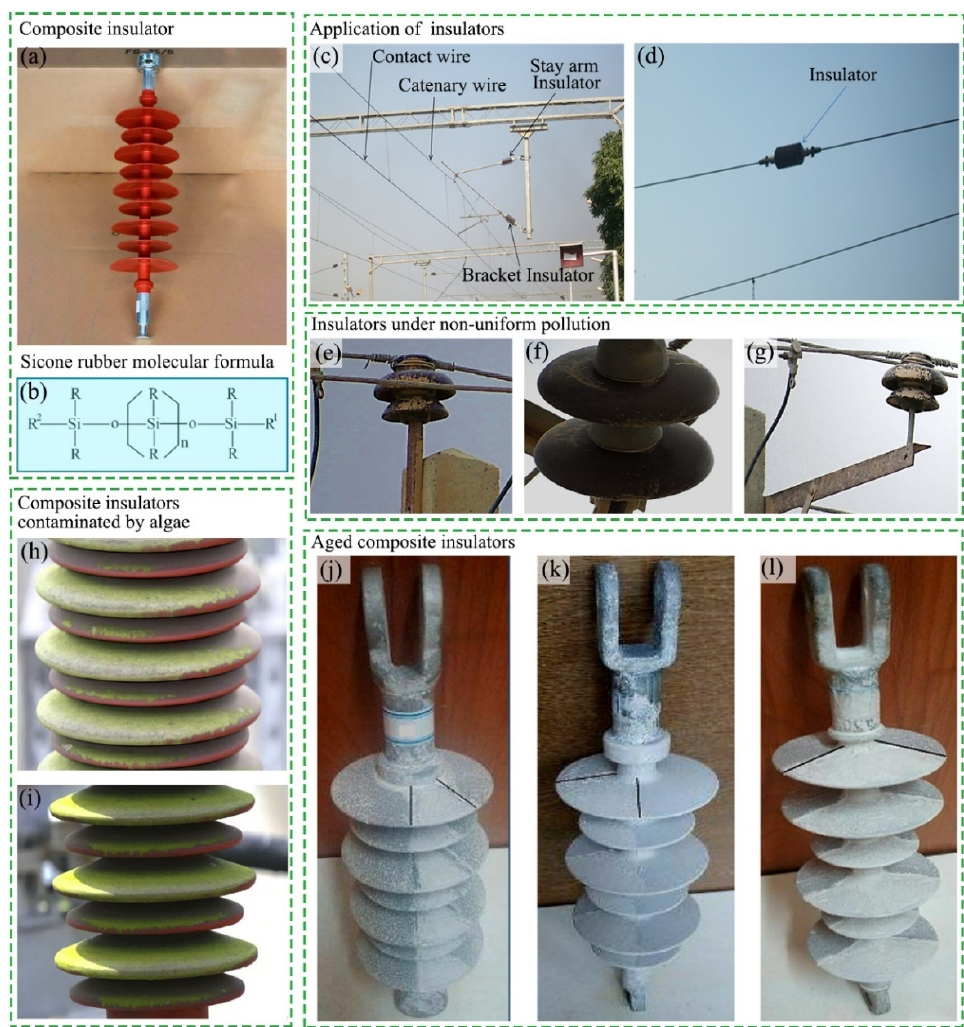
Figure 1. Application and aging of composite insulators. ( a ) Composite insulators. ( b ) Molecular formula of silicone rubber. ( c , d ) Application of a composite insulator in a railway overhead system. ( e – g ) Energized insulators of alternating current (AC) overhead lines under fan-shaped non-uniform pollution. ( h , i ) Composite insulators polluted by algae in different degrees. ( h ) One direction of the shed full of algae, including the inside of the shed. ( i ) Major of the shed thoroughly covered with algae contaminates. ( j – l ) Composite insulator with artificial accelerated aging for ( j ) 2 weeks, ( k ) 4 weeks, and ( l ) 6 weeks.